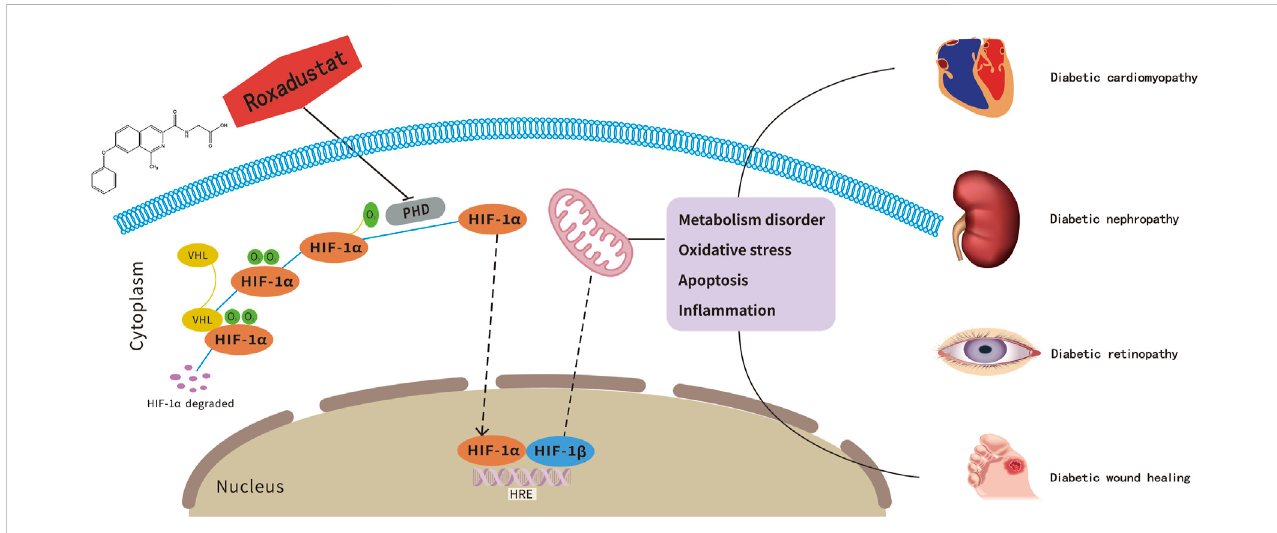
FIGURE 1 Roxadustat, apotential therapeutic drug for diabetes-related complications treatment. The pathogenesis of diabetes-related complications isrelated to the HIF-1 α -mediated metabolic imbalance. As an inhibitor of HIF-PHD, roxadustst shows potentially therapeutic effects on diabetic